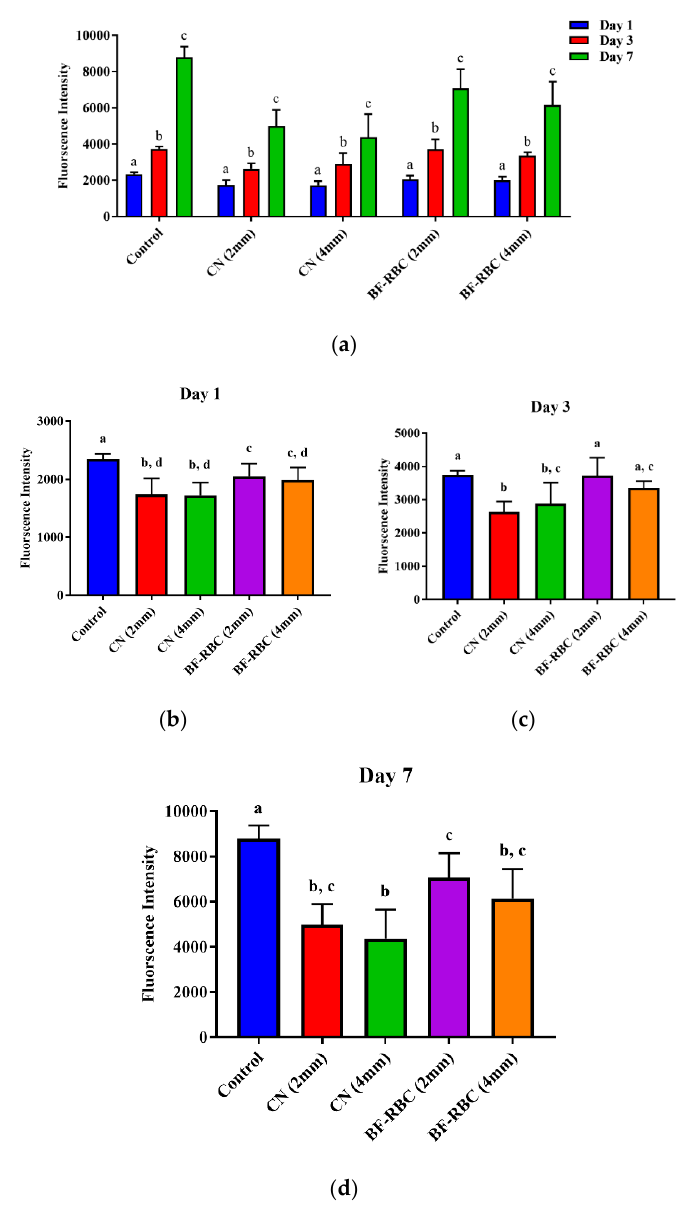
Figure 4. E ff ect of RBCs on the proliferation and activity of human gingival fibroblast cells